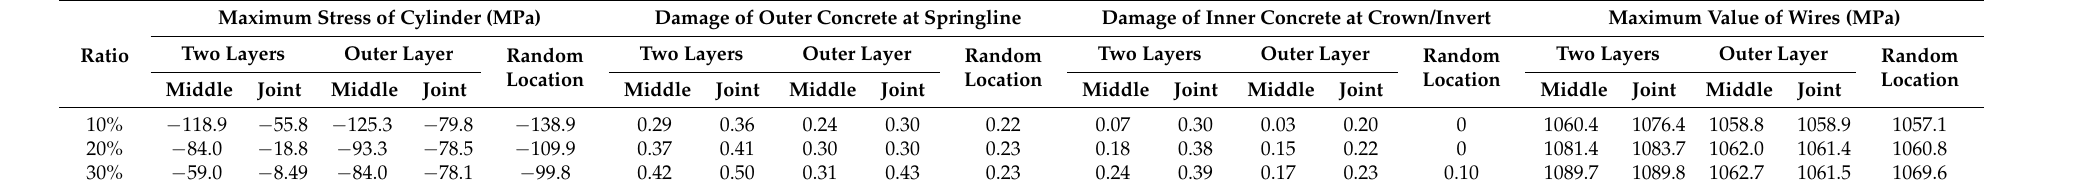
Table 7. The main analyzing index value of pipe No.1.